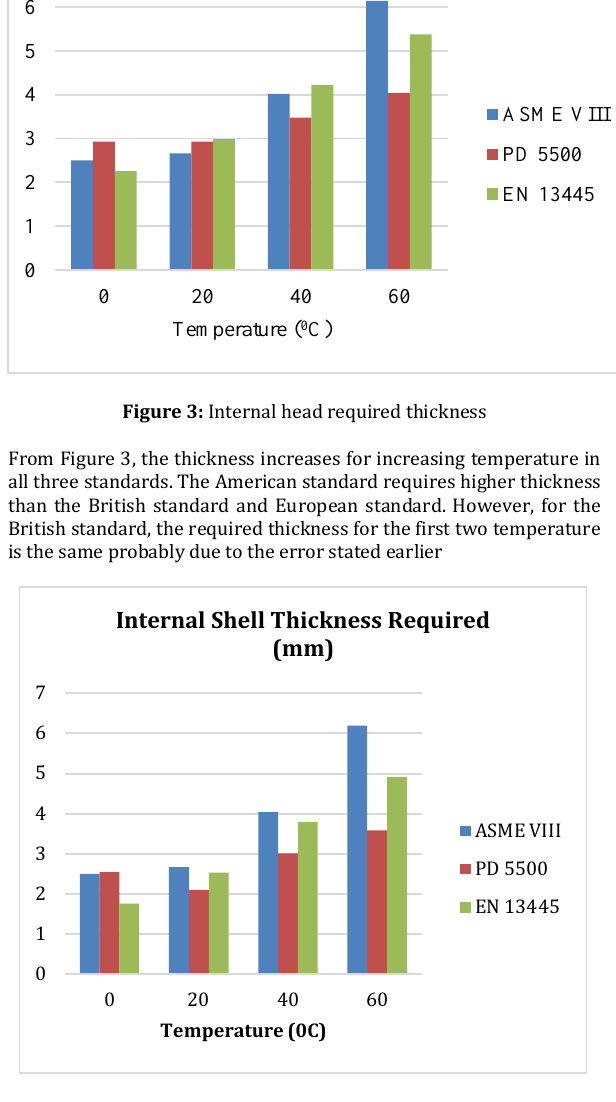
Figure 4: Internal shell required